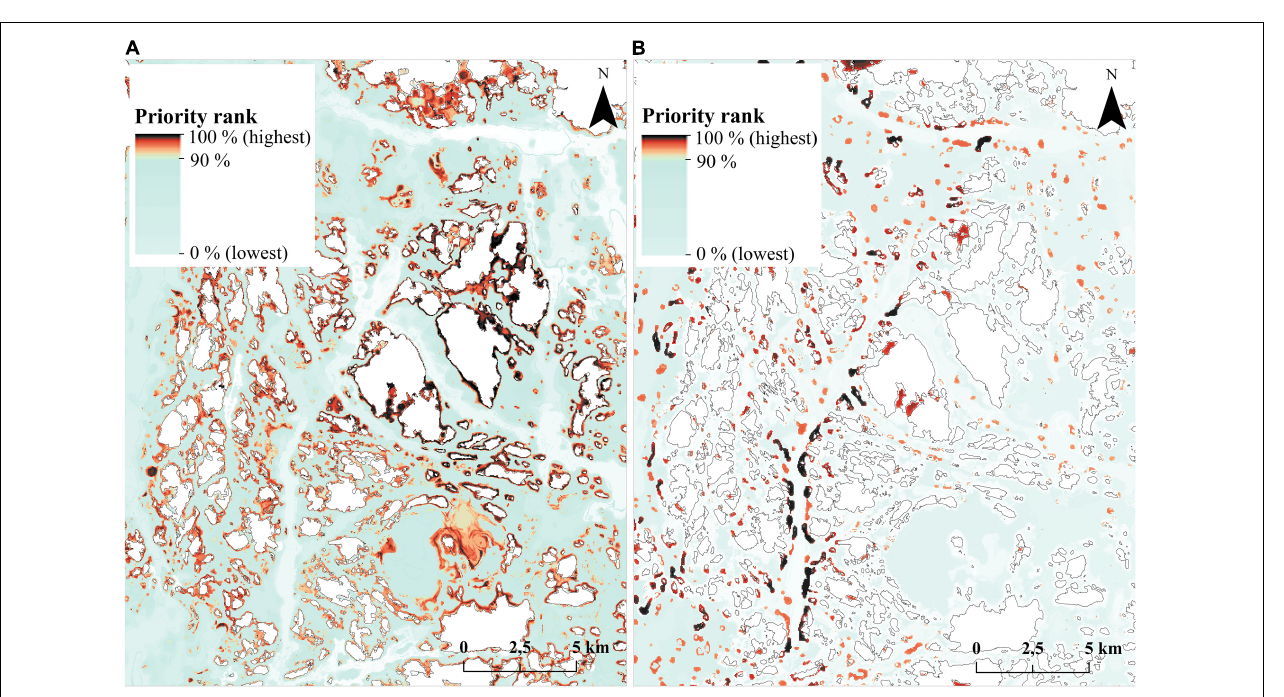
FIGURE 10 | Surrogacy analysis priority rank maps in an example area in the Archipelago Sea. (A) Priority rank map based on species data. (B) Priority rank map based on habitat data. Priorities in this region differ substantially between the two analyses. Corresponding performance curves are shown in Figure 9